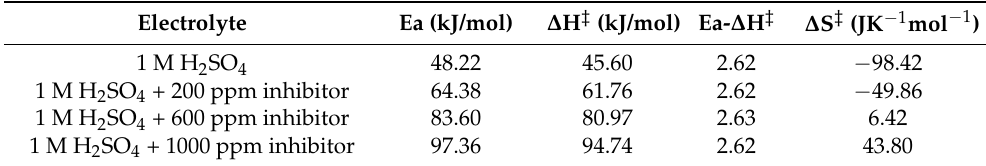
Table 3. Activation parameters of the MS dissolution in the 1 M H 2 SO 4 , both without and with an